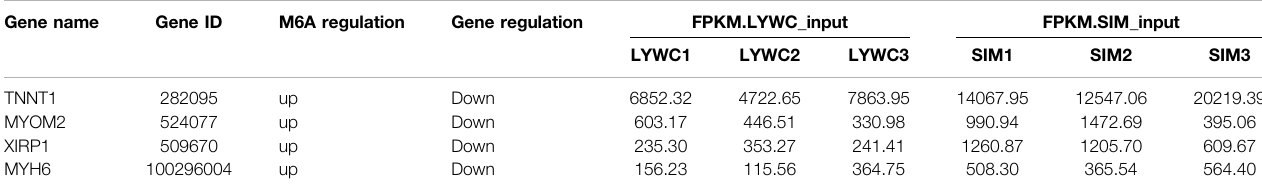
TABLE 6 | M6A -modi fi ed candidate genes related to muscle cell growth and development.